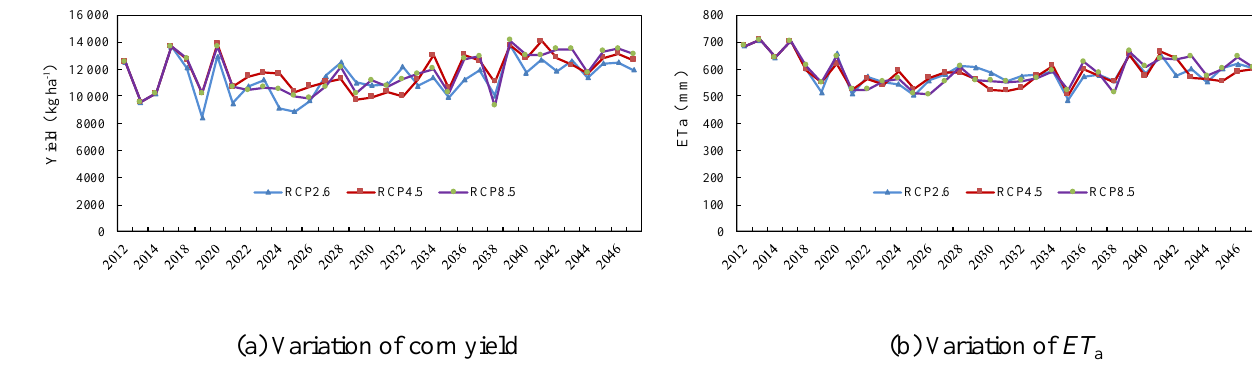
Figure 6. Temporal variations of corn yield and ET a in the Ganzhou area under RCP scenarios.